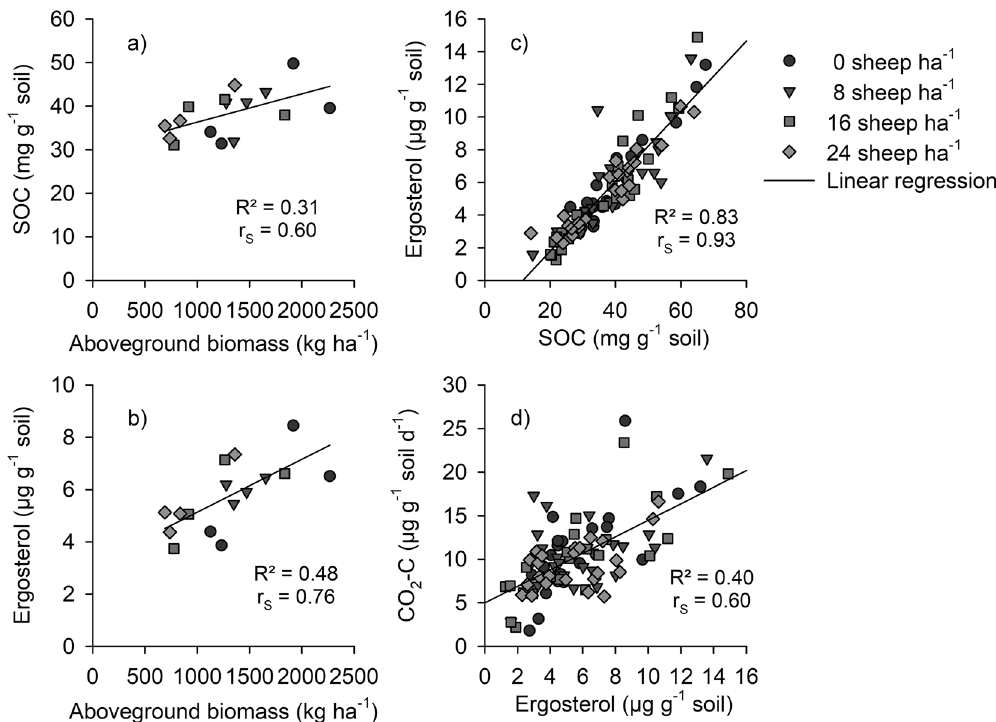
Figure 2. Correlations between aboveground biomass and SOC ( a , n = 16), aboveground biomass and ergosterol ( b , n = 16), SOC and ergosterol ( c , n = 96), and ergosterol and basal respiration ( d , n = 96) of a rangeland soil across all grazing intensities (0, 8, 16, and 24 sheep ha −1 ) at the end of a two year grazing experiment from 2014–2015 on a summer pasture in the Chinese Altai Mountains, Qinghe,